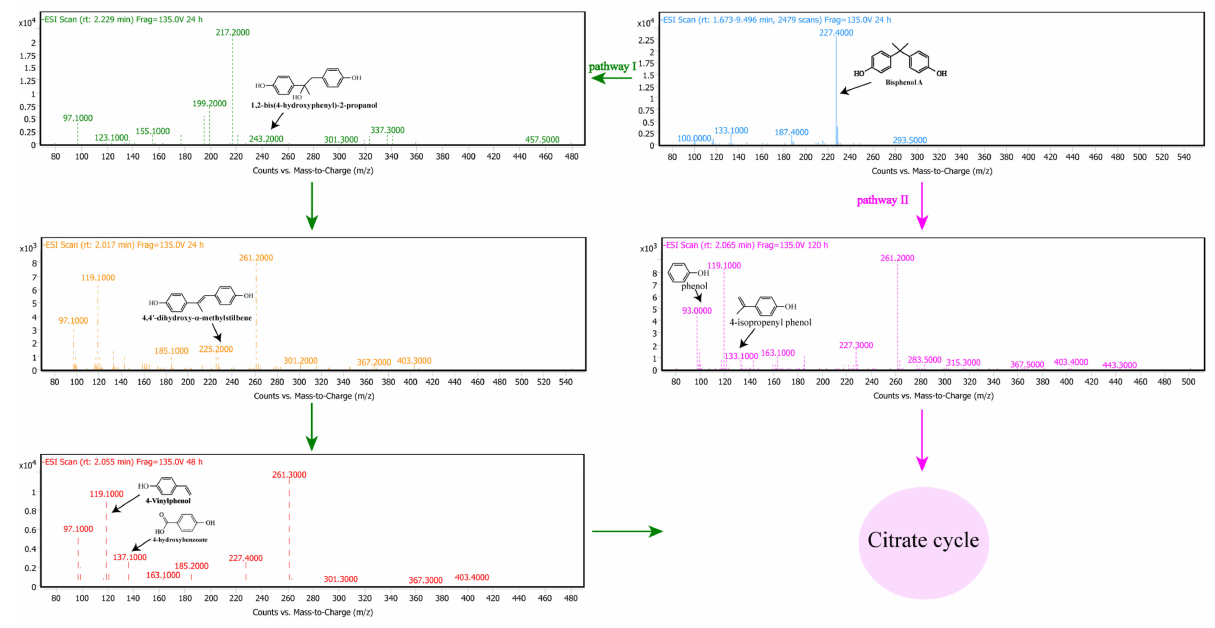
Figure 5. Two pathways for Pseudomonas sp. P1 to degrade BPA. The green arrows represent BPA conversion through pathway I, and the pink arrows represent BPA conversion through pathway II.